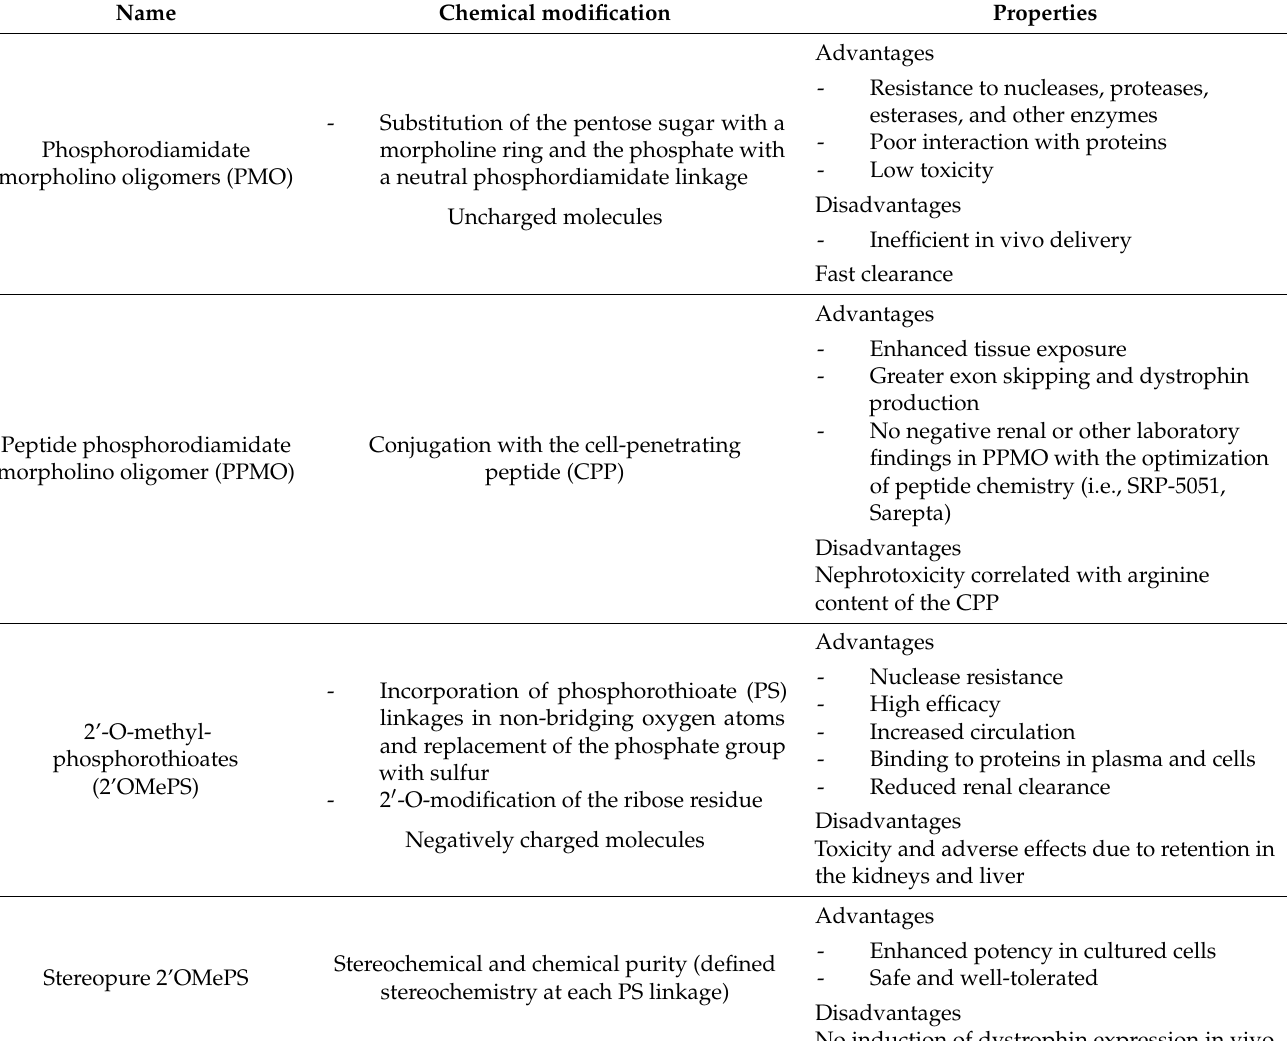
Table 2. Chemical modifications of AON molecules used in DMD